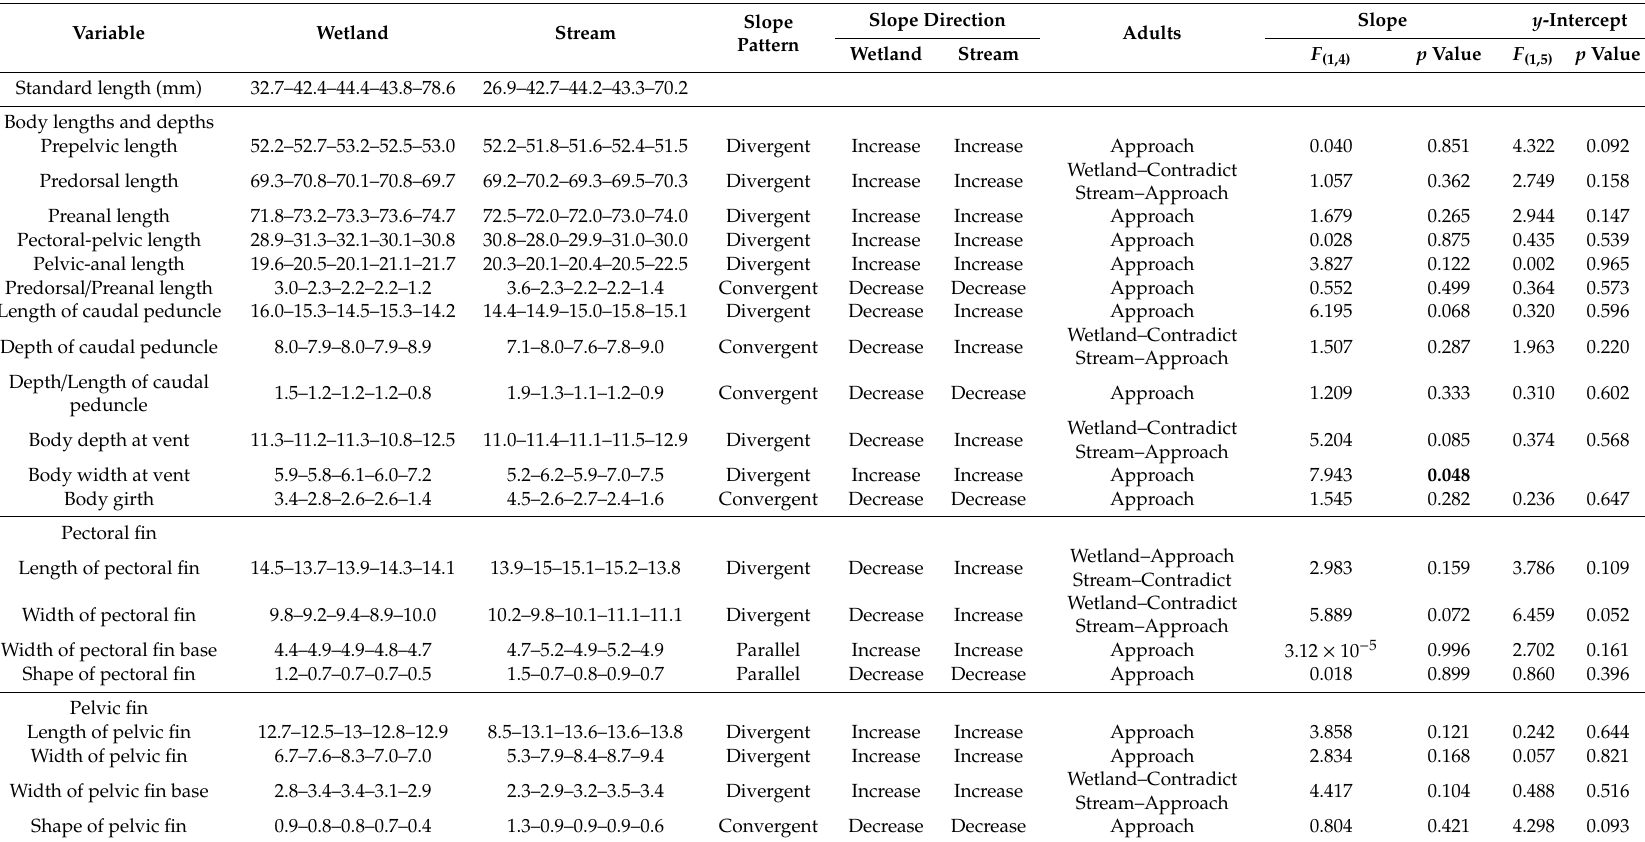
Table A1. Standard length (mm) and untransformed seasonal (summer–autumn–winter–spring) mean percentages of standard-length standardised variables for wetland and stream field, and adult G. gollumoides . Slope pattern and directions describe growth trajectories and whether these approach or contradict the morphological condition observed in adults. Results of homogeneity of slope and y -intercepts tests: Bold text—significant at p <